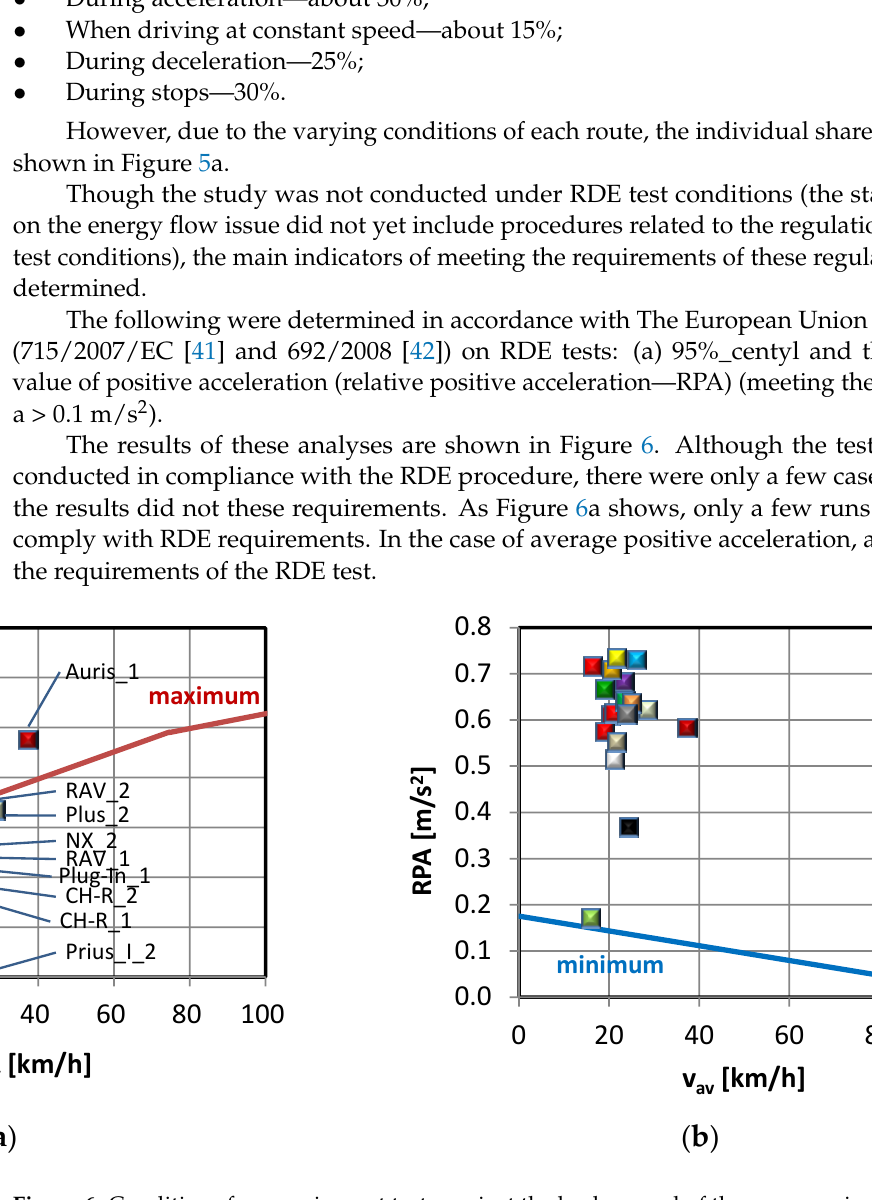
Figure 5. Analysis of vehicle traffic conditions: ( a ) percentage of time and distance traveled, as well as initial and final battery state of charge; ( b ) share of acceleration, constant speed, braking, stop- ping; ( c ) average speed (S — normalized distance; t — normalized time; SOC-s — SOC at the start test; SOC-e — SOC at the end test; a — acceleration; stop — normalized stop time of the car; V — vehicle